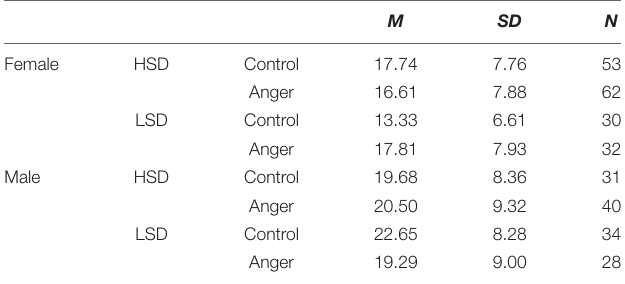
TABLE 2 | Means and standard deviations of trust by emotion, social distance and gender in Study 2.